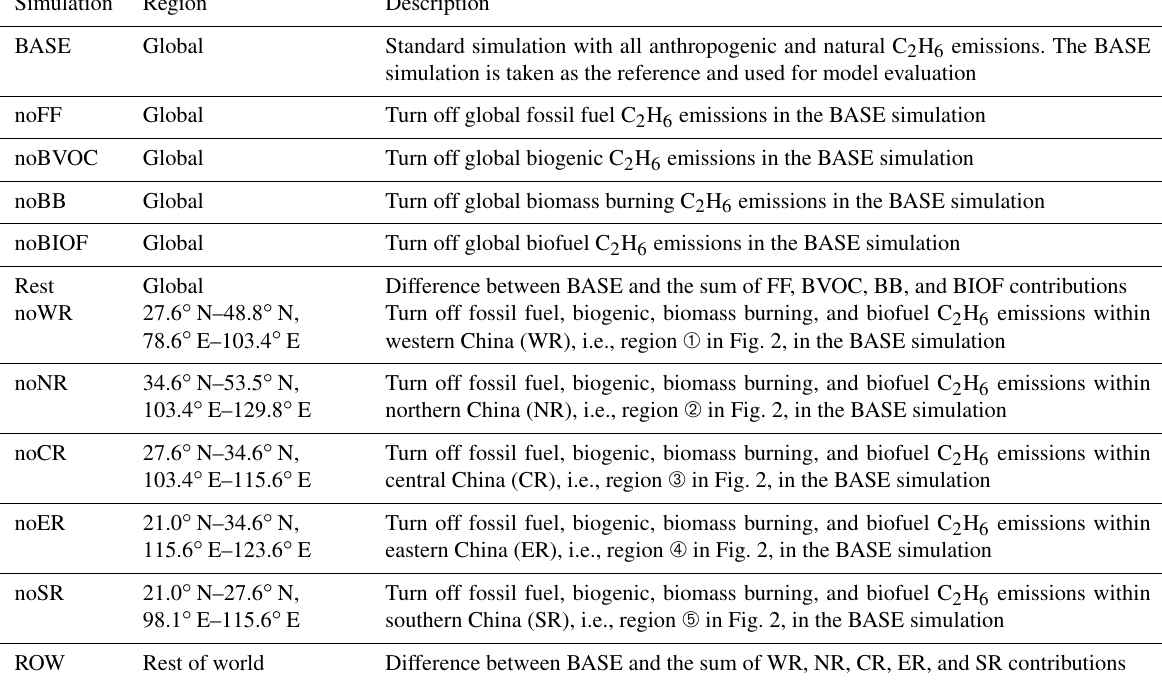
Difference between BASE and the sum of WR, NR, CR, ER, and SR